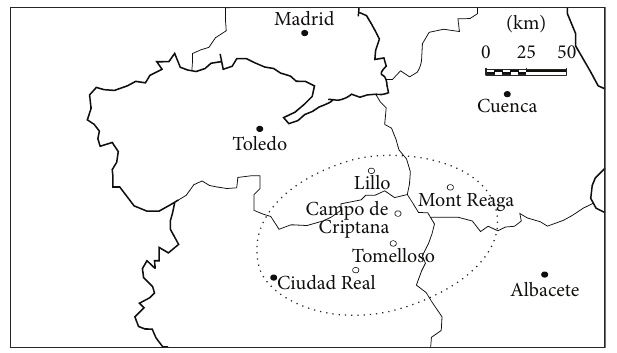
Figure 1: Location map of the studied area and sampling soil profile